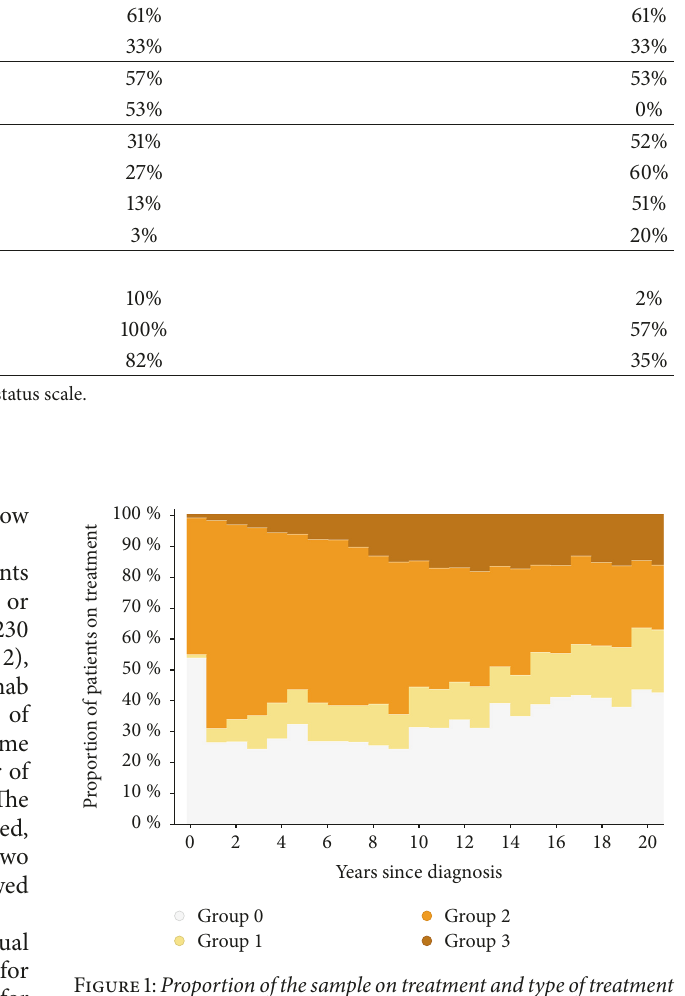
Figure 1: Proportion of the sample on treatment and type of treatment since disease onset. The vast majority of patients at onset were treated with group 2 treatments (interferons/glatiramer acetate), with a gradual switch to group 3 (natalizumab/fingolimod). The propor- tionofpatientsusinggroup1drugsaloneissmallandremainsstable. (Groups 2 and 3 may include patients on combination therapy with group 1, while combination of groups 2 and 3 is very